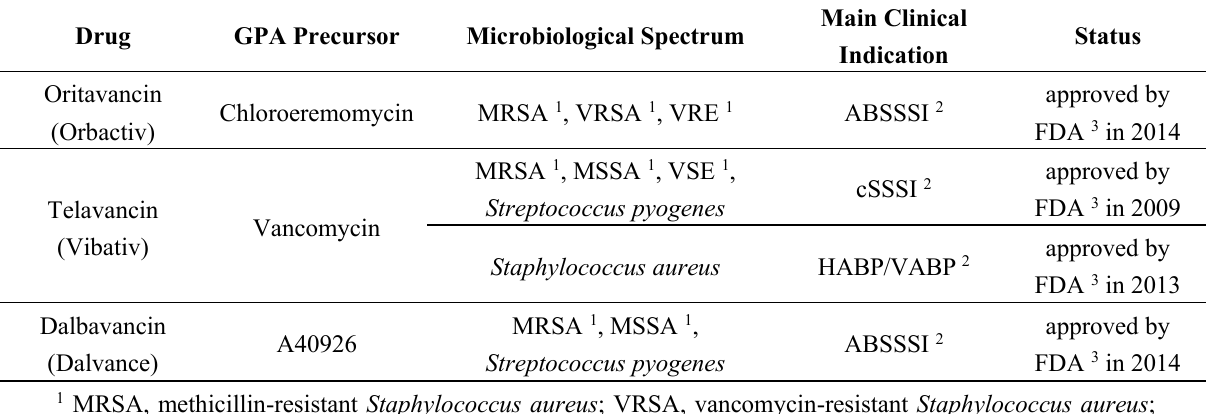
Table 1. Second generation GPAs approved and/or in development